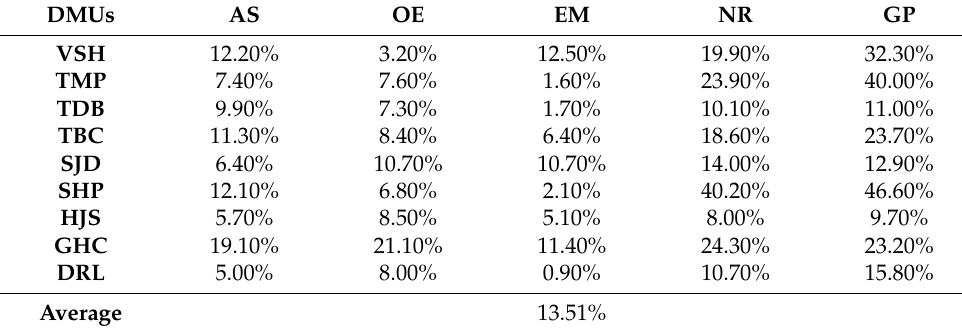
Table 4. Classification of MAPE